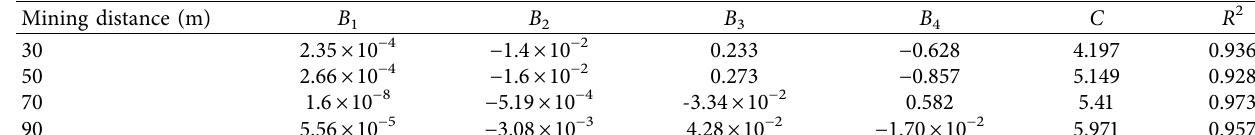
Table 3: Stress distribution curve-fitting parameters.